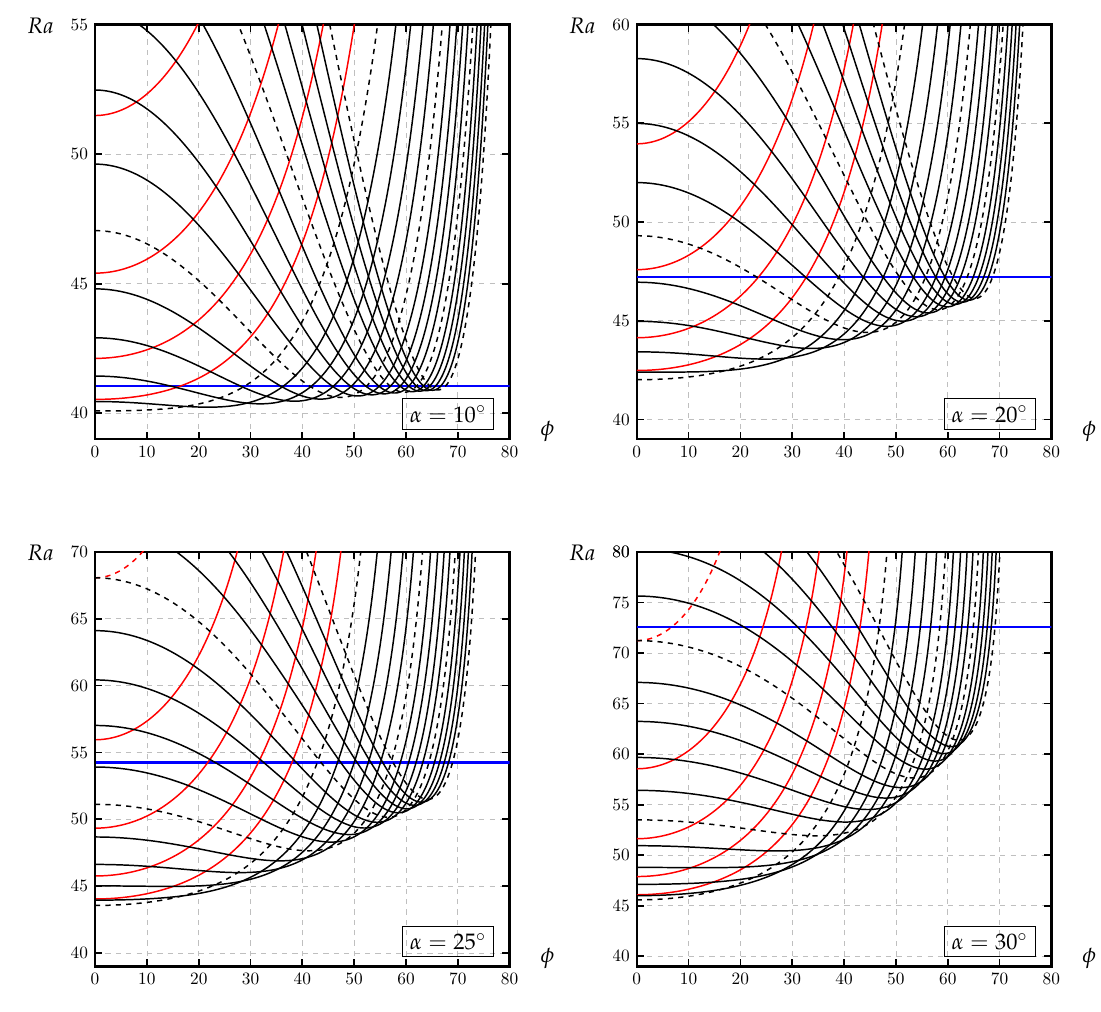
Figure 2. Critical values of Ra against φ for the n = 2 mode, the following values of L : L = 0.6, 0.8 (0.2) · · · 5, and for the indicated inclinations from the horizontal. The red curves denote those values of L which are less than n . The dotted lines correspond to integer values of L while the rightmost curve is for L = 5. The blue horizontal line corresponds to transverse